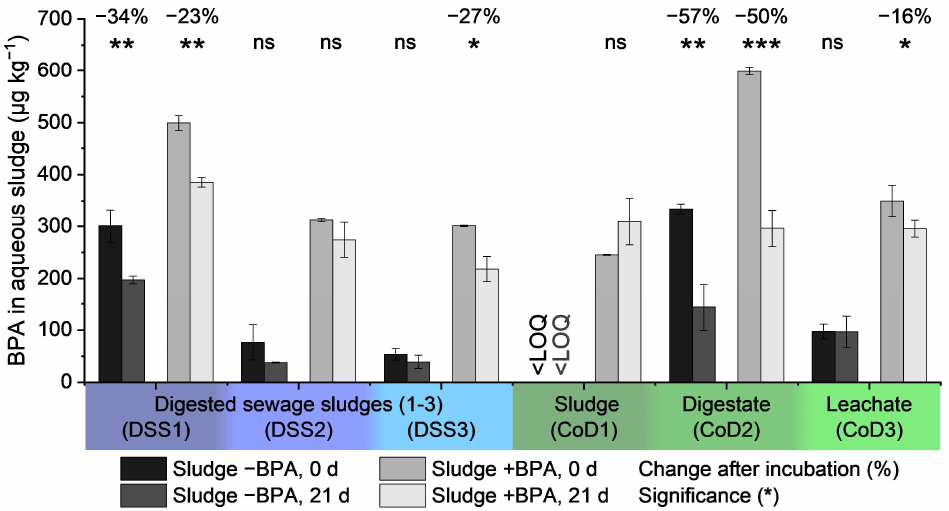
Figure 5. The anaerobic removal efficiency of bisphenol A for different sludge types. BPA concen- trations in aqueous sludge (µg kg −1 ) are shown before and after digestion for 21 days in different anaerobic sludges. Spiked sludges (+BPA) received 228 µg kg −1 of BPA, and untreated samples (−BPA) were used without additional BPA. Anaerobic batch digestion occurred with three different digested sludges from WWTPs and seed sludges from three different co-digester plants. Standard deviations of the triplicates are represented by error bars. The significance level of removal is highlighted above each pair of bars, with the percentage change of BPA concentration (= −% removal efficiency) for significant values. A p -value > 0.05 was considered not significant (ns), while p -values ≤ 0.05 were considered significant, with p ≤ 0.05 (*), ≤0.01 (**), and ≤0.001 (***). We observed that the higher the BPA concentration, the higher the absolute removal (−BPA: Pearson correlation coefficient r = 0.921, n = 5, p < 0.05; +BPA: r = 0.858, n = 6, p < 0.05; Figure 6), which indicated a first-order reaction.